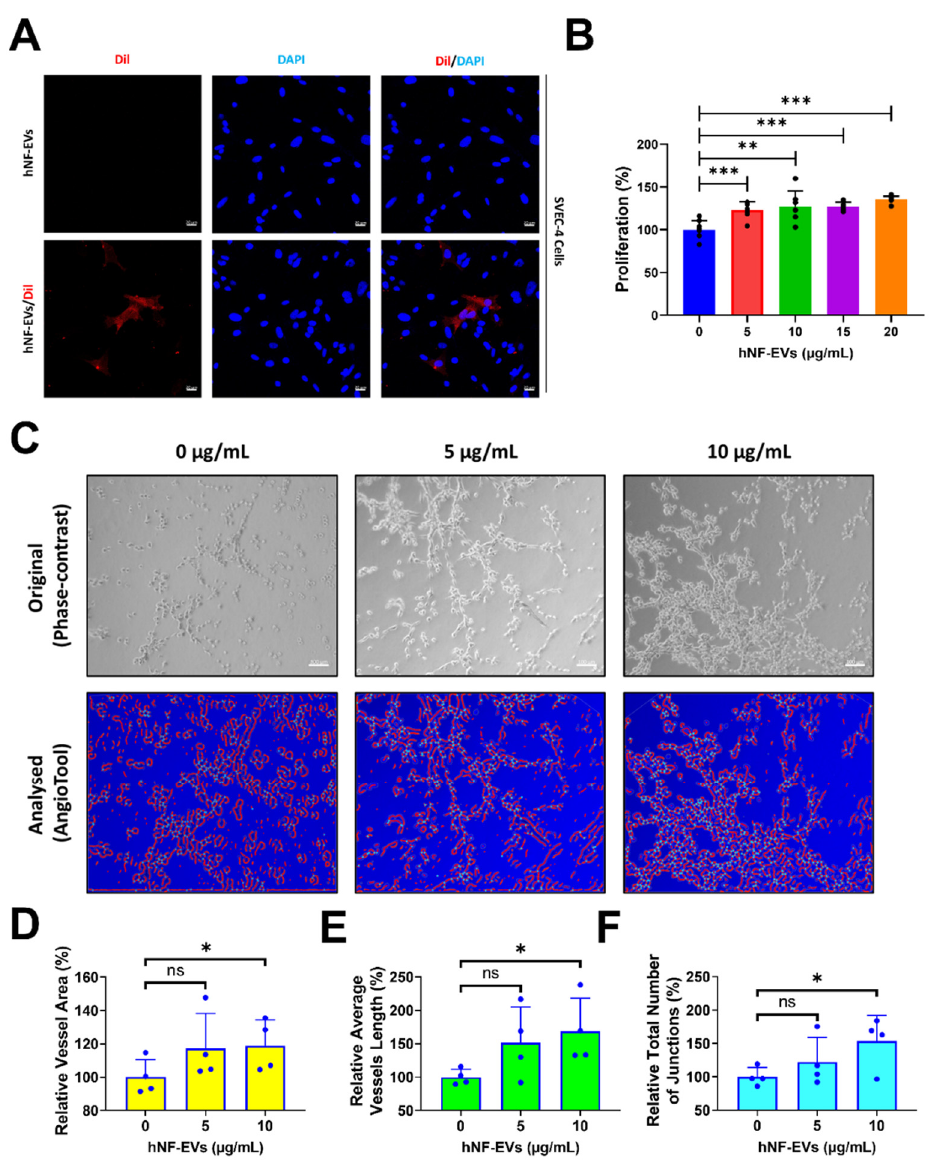
Figure 5. hNF-EV treatment promotes angiogenesis in vitro. ( A ) Fluorescent microscopy imaging of SVEC-4 cells treated with 10 µg/mL of hNF-EVs or hNF-EVs/DiI (scale bar: 20 µm). ( B ) The cellular proliferation of SVEC-4 cells treated with increasing concentrations of hNF-EVs (0, 5, 10, 15, and 20 µg/mL) for 24 h, quantified using a CCK8 assay kit ( n = 6). ( C ) Original phase-contrast and analyzed images showing endothelial cells cultured on Matrigel-coated plates in media with 0, 5, or 10 µg/mL hNF-EVs (scale bar = 100 µm); ( D – F ) Bar graph of the relative vessel lengths, relative average vessel lengths, and relative total number of junctions measured in the field of view ( n = 4) using AngioTool64 software, (National Cancer Institute, Radiation Oncology Branch, Angiogenesis Core Facility, MD, USA) Version 0.6a (02.18.14). * p < 0.05; ** p < 0.01; *** p < 0.001 and ns: not significant. A